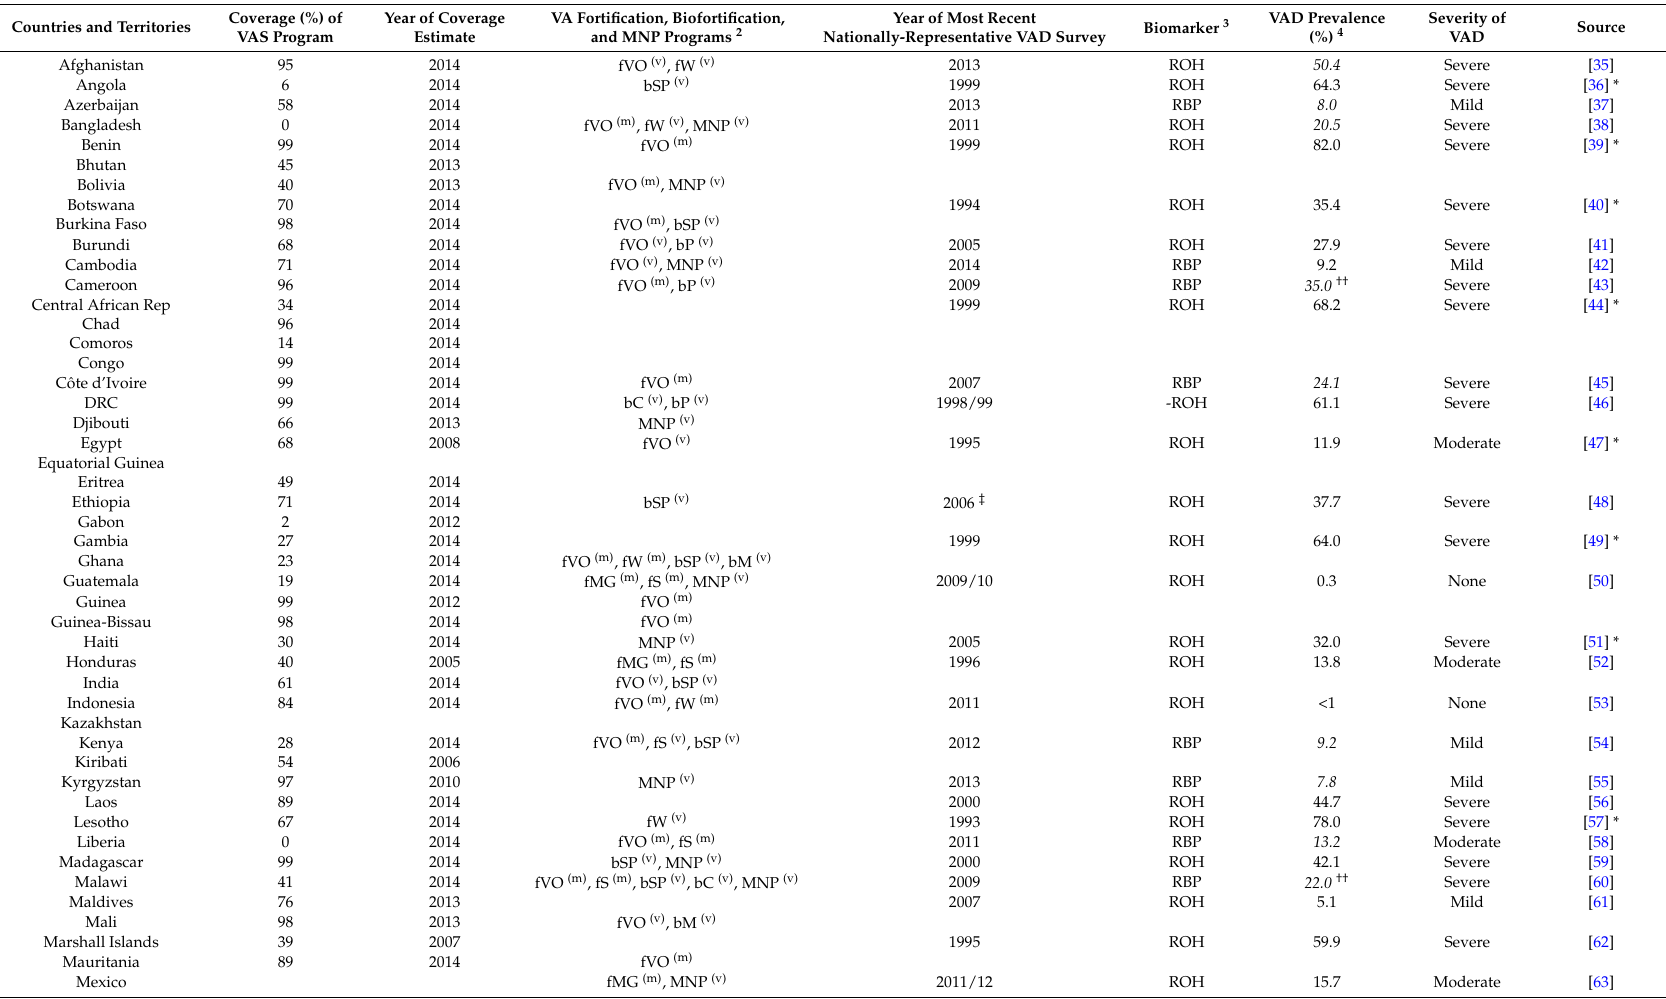
Table 1. The most recent estimates of VAS coverage, presence of other VA programs, and VAD prevalence in countries in UNICEF’s SOWC VAS coverage database 1 . Countries and